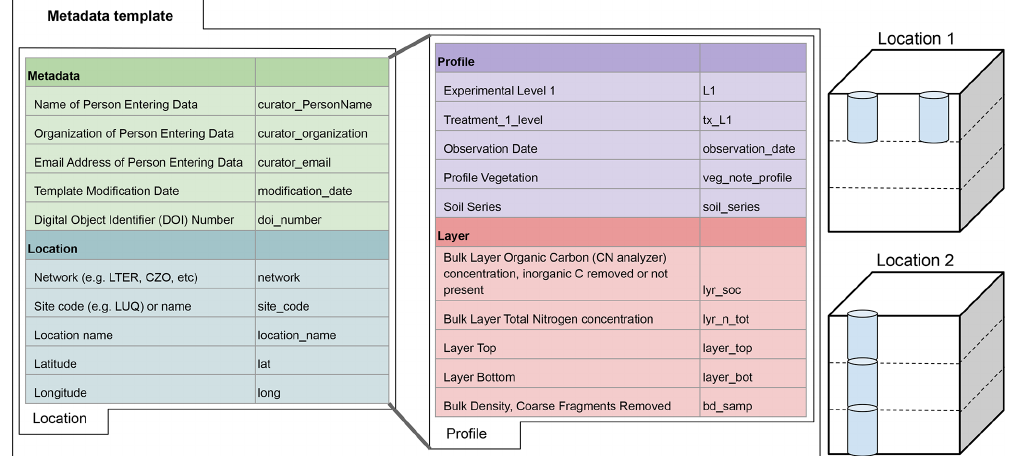
Figure 2. Diagram showing hierarchical relationship between data fields in the Soils Data Harmonization (SoDaH) database, which includes metadata, location, profile, and layer fields. Each data field lists a short description of some of the variables used along with the variable name used in the database. To facilitate data contributions these data fields were grouped into “location” and “profile” tabs on the metadata template used by data contributors. The right side of the figure illustrates data from two hypothetical locations (e.g., a LTER and CZO site, respectively) where Location 1 includes data from two profiles that each have information from one layer. Location 2 provides data from one profile that has information from three layers. Any location may provide data from multiple profiles or layers. With data harmonization data for each profile and layer will inherit metadata and location data that are provided in the location